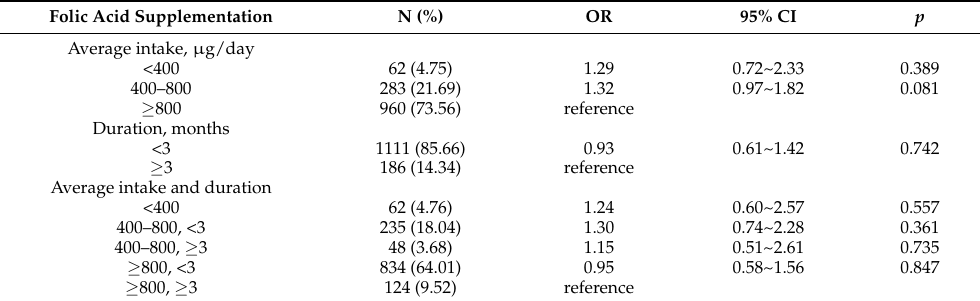
Table 3. ORs and 95% CI of GDM risk associated with early pregnancy folic acid